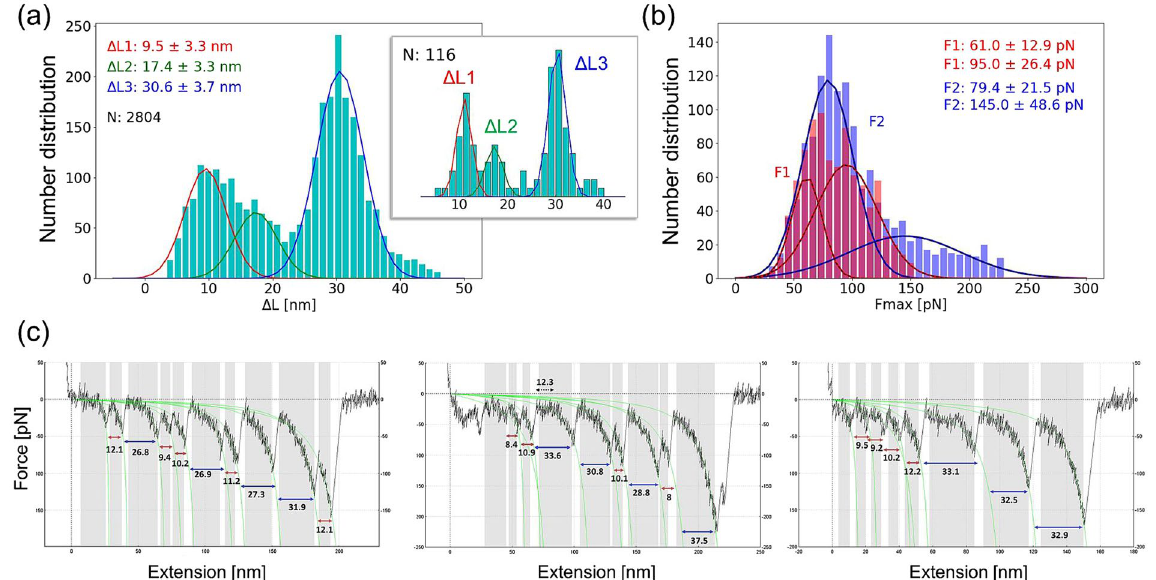
Figure 3. Distribution of unfolding lengths ( Δ L, in nm) and maximal forces obtained from WLC fitting of experimental data. ( a ) Results from fitting a total of 2,804 unfolding by two Gaussian functions with respective mean values of Δ L = 9.5 ± 3.3 nm and 17.4 ± 3.3 nm (corresponding to IgC2 domains) and 30.6 ± 3.7 nm (FnIII domains). The inset displays the histogram obtained from 21 most representative unfolding curves (116 peaks), which indicates similar results: Δ L 1 : 11.0 ± 1.6 nm, Δ L 2 ≈ 17.2 ± 1.8 nm and Δ L 3 : 30.4 ± 1.8 nm. ( b ) The distribution of maximal forces (F max , in pN) obtained from WLC model. Data for IgC2 domains ( red ) are fit by three Gaussian distributions, with mean values: 61.0 ± 12.9 and 95.0 ± 26.4 pN; and those for FnIII, by two Gaussians with means 79.4 ± 21.5 and 145.0 ± 48.6 pN. ( c ) Example of force-extension curves with WLC